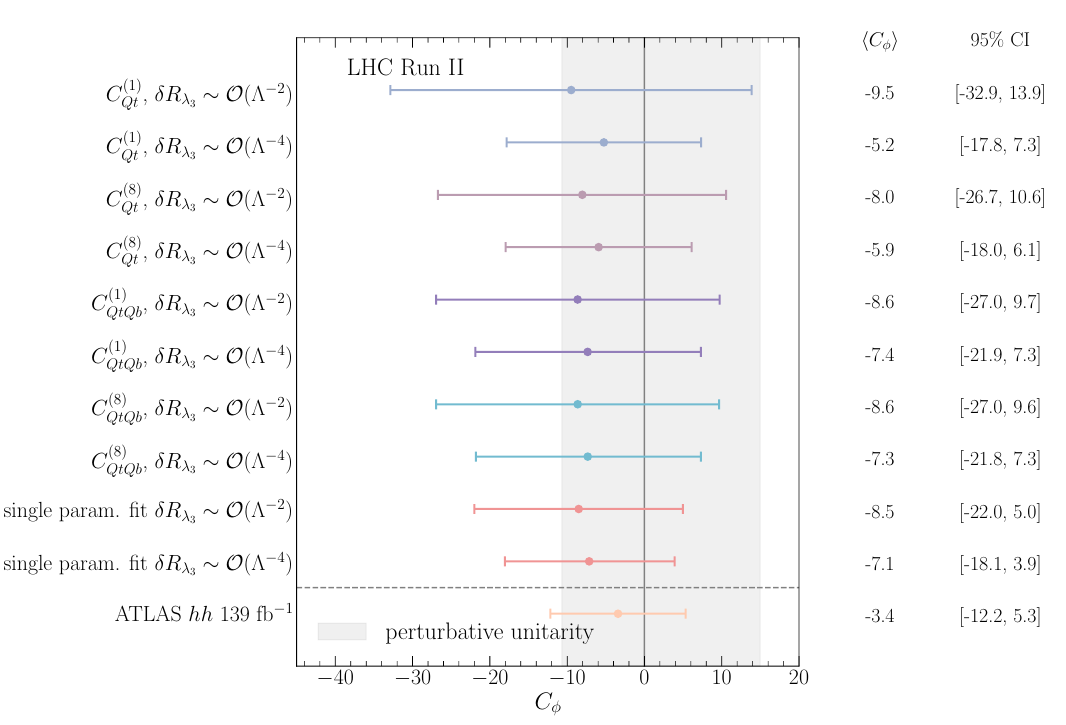
. For comparison, 3